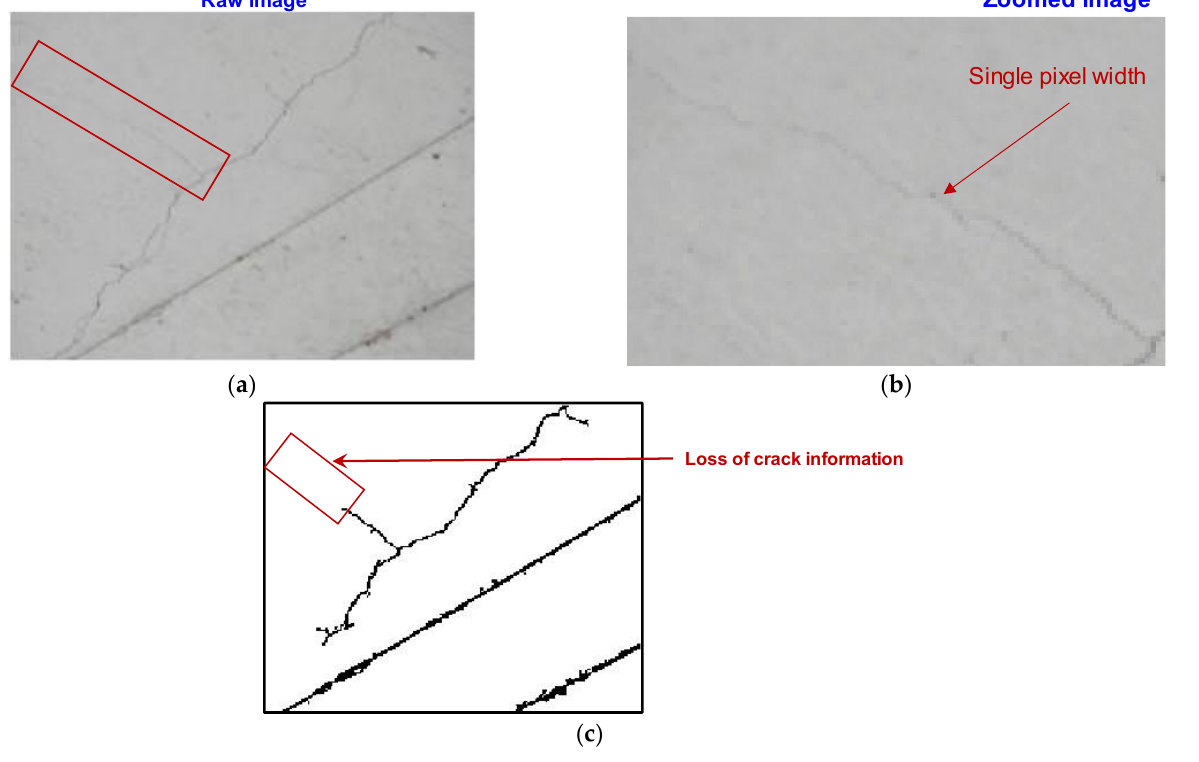
Figure 6. ( a ) Representative raw image and ( b ) zoomed region showing single-pixel width crack. ( c ) Loss of crack information during noise filtering post adaptive-threshold-based integral image binarization.